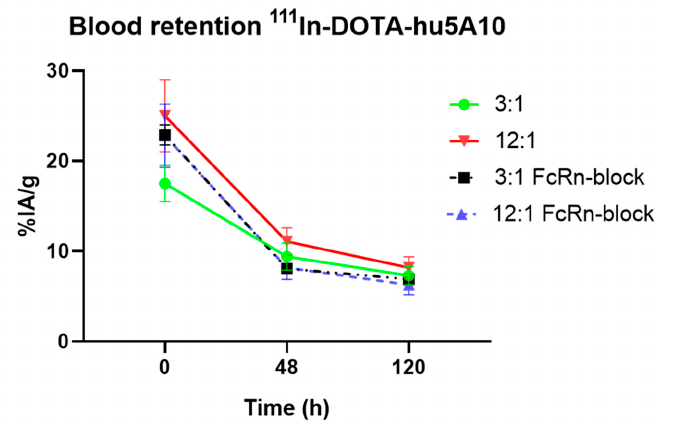
Figure A1. Blood retention for 111 In-DOTA-hu5A10 with 3:1 and 12:1 chelate-to-antibody molar ratios. The results for FcRn blocking are also included. As can be seen, there was an accelerated blood clearance observed for ratio 3:1. FcRn blocking enhanced the blood retention for both ratios. Results from SPECT imaging performed at 0, 2, and 5 days post-injection. Table A1. The biodistribution for 111 In-CHX-A ″ -DTPA-hu5A10 and 111 In-DOTA-hu5A10 with 3:1, 6:1, and 12:1 chelator- to-antibody molar ratios in LNCaP xenografted BALBC-nu mice.